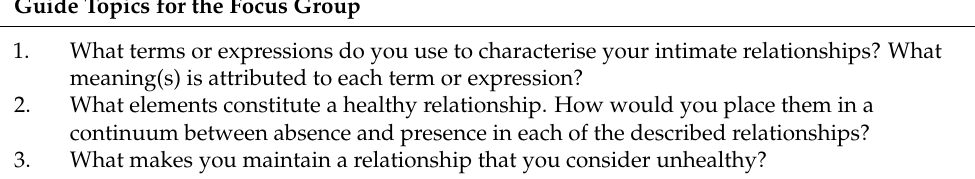
Table 2. Focus group guiding topics. Guide Topics for the Focus